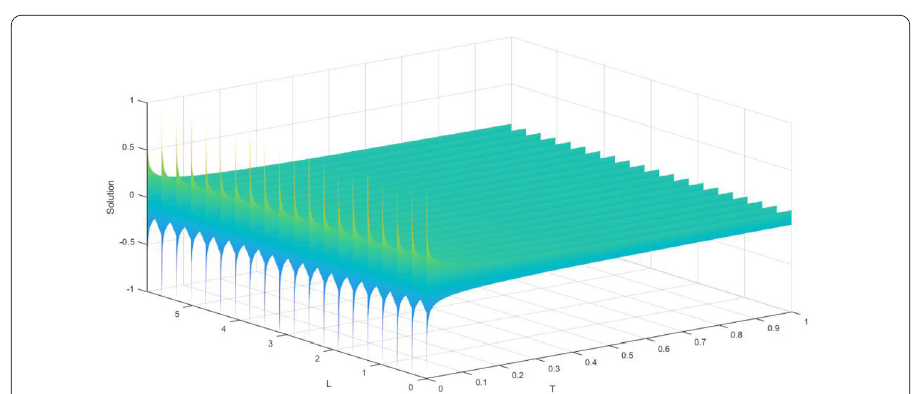
Figure 2 The dynamic behavior of solution for α = 0.7